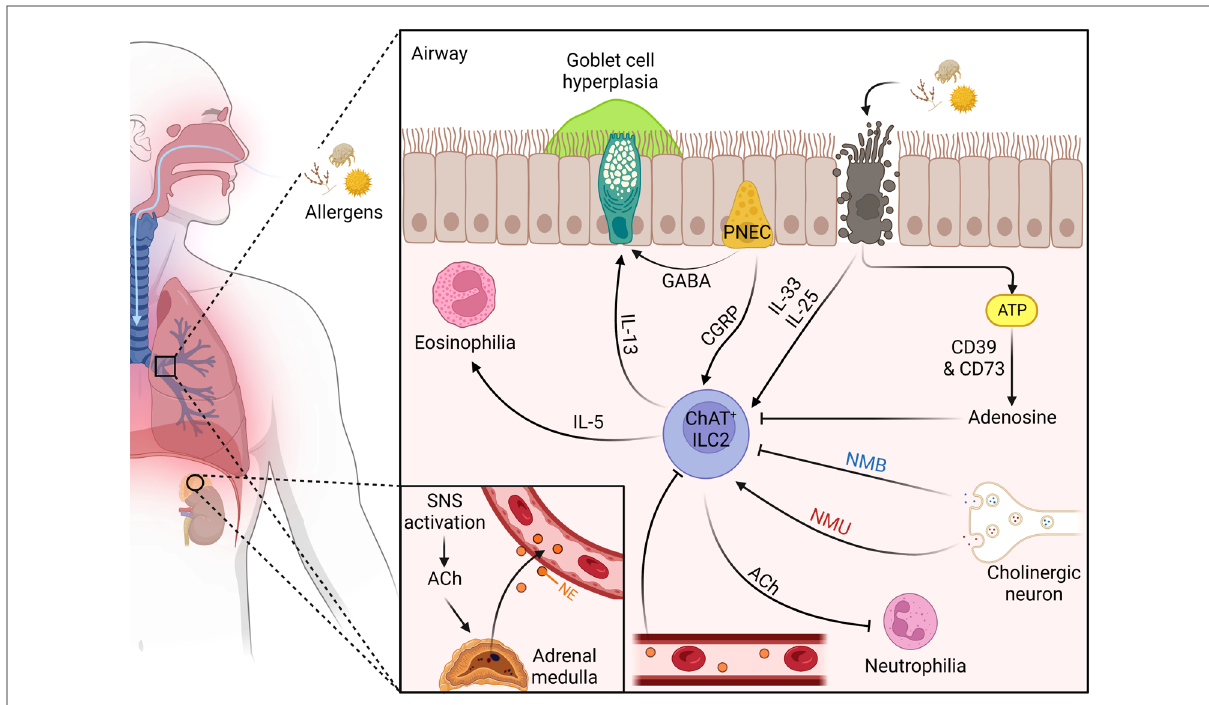
FIGURE 1 The dynamic neuro-regulation of ILC2s in the lungs upon allergen challenge. (1) Inhaled allergen enters through the nasal cavity and makes its way to the distal airway. (2) PNECs located at branch junctions detect the allergen and release CGRP and GABA, promoting IL-5 release from ILC2s and goblet cell hyperplasia, respectively. (3) The proteolytic allergen disrupts tight junctions between epithelial cells leading to their death and the release of alarmins IL-25 and IL-33, and exogenous ATP. (4) exogenous ATP is quickly degraded into adenosine by ectonucleotidases CD39 and CD73 to suppress ILC2s. (6) IL-25/IL-33 activates the conical type 2 cytokine pathway promoting eosinophilia and goblet cell hyperplasia, as well as upregulates ChAT expression. (7) ChAT+ILC2s secrete ACh which suppresses airway neutrophilia. (8) Mucosal cholinergic neurons release NMU and NMB in response to allergen challenge. (9) NMU and IL-25 work synergistically to amplify type 2 in fl ammation. (10) NMB controls allergic type 2 in fl ammation by suppressing IL-5 and IL-13 release. (11) Allergen challenge leads to sympathetic activation and the release of ACh which promotes the adrenal medulla to secrete NE into the bloodstream where it travels to the lungs to suppress ILC2s. Figure 1 was created using BioRender (https://biorender.com/). Abbreviations: ACh, acetylcholine; CGRP, calcitonin gene-related peptide; ChAT, choline acetyltransferase; GABA, γ -aminobutyric acid; IL, interleukin; ILC2, type 2 innate lymphoid cell; NE, norepinephrine; NMB, neuromedin B; NMU, neuromedin U; PNEC, pulmonary neuroendocrine cell; SNS, sympathetic nervous